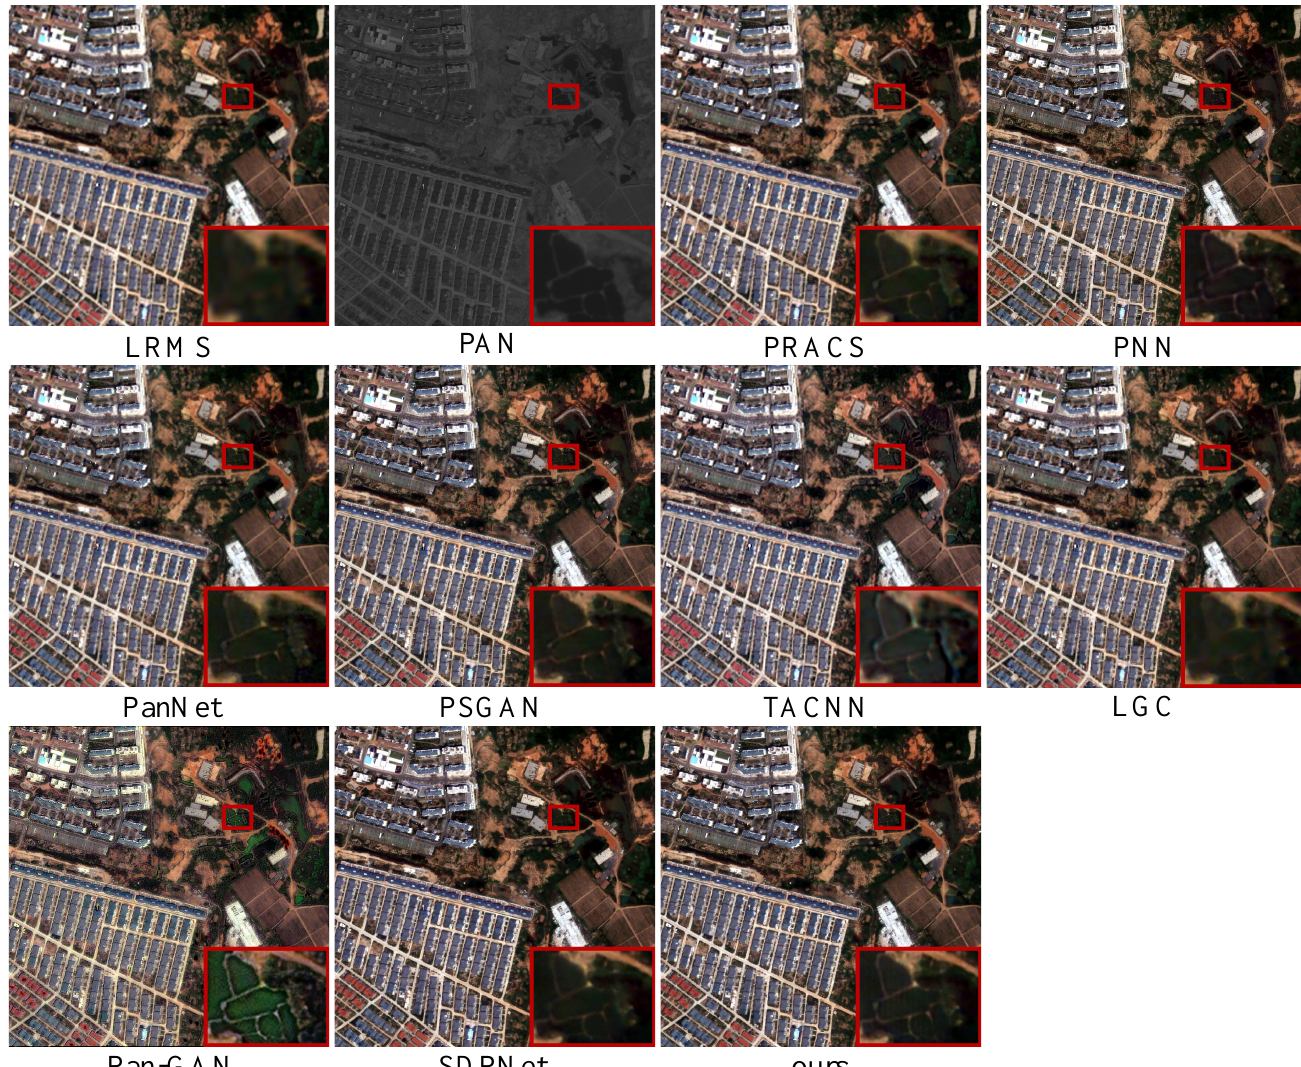
Figure 13. Qualitative comparison of CPNet with other eight pan-sharpening methods on the data from the QuickBird data set in full-resolution